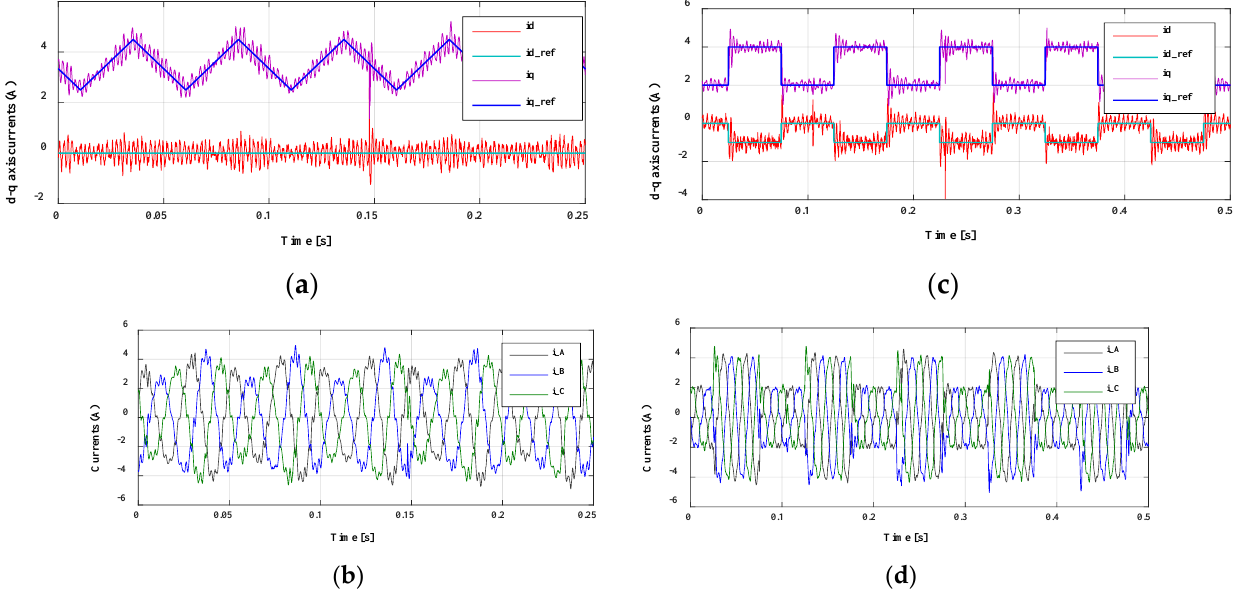
Figure 16. The measured waveforms: ( a ) the measured d- and q-axes currents with i q-ref is changing as a triangular wave; ( b ) the measured three-phases’ currents with i q-ref is changing as a triangular wave. ( c ) the measured d- and q-axes currents with i d-ref and i q-ref changing as square waves; ( d ) the measured three-phases’ currents with i d-ref and i q-ref changing as square